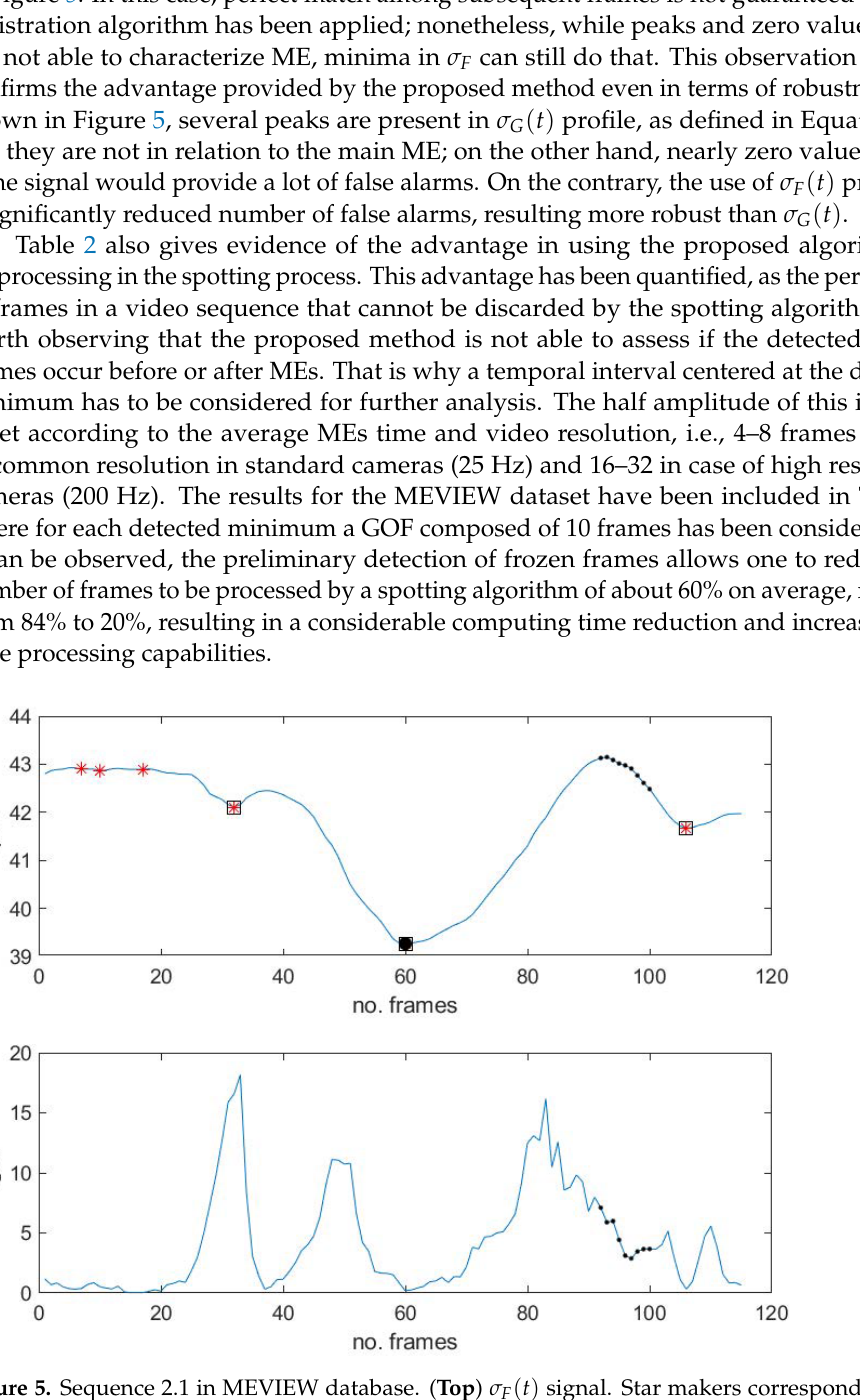
Figure 5. Sequence 2.1 in MEVIEW database. ( Top ) σ F ( t ) signal. Star makers correspond to local minima; square markers are the three selected minima—the absolute one is emphasized. Dots correspond to frames involving MEs. ( Bottom ) σ G ( t ) signal. Dots correspond to frames involving MEs. They do not correspond to evident impulsive